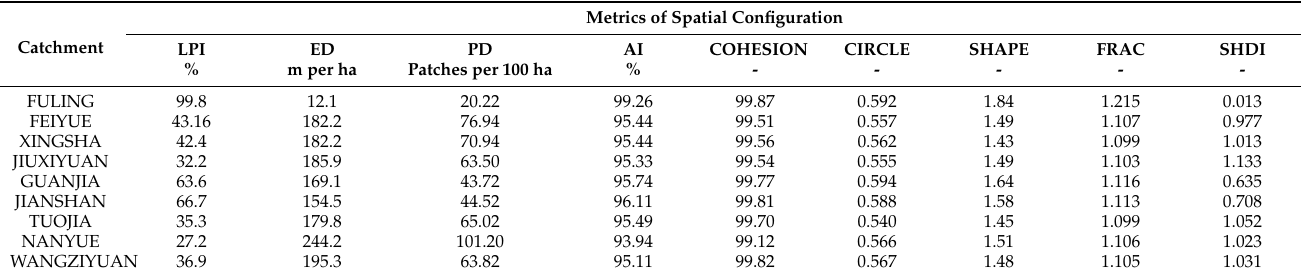
Table 4. Landscape metrics of the spatial configuration of the nine studied catchments.